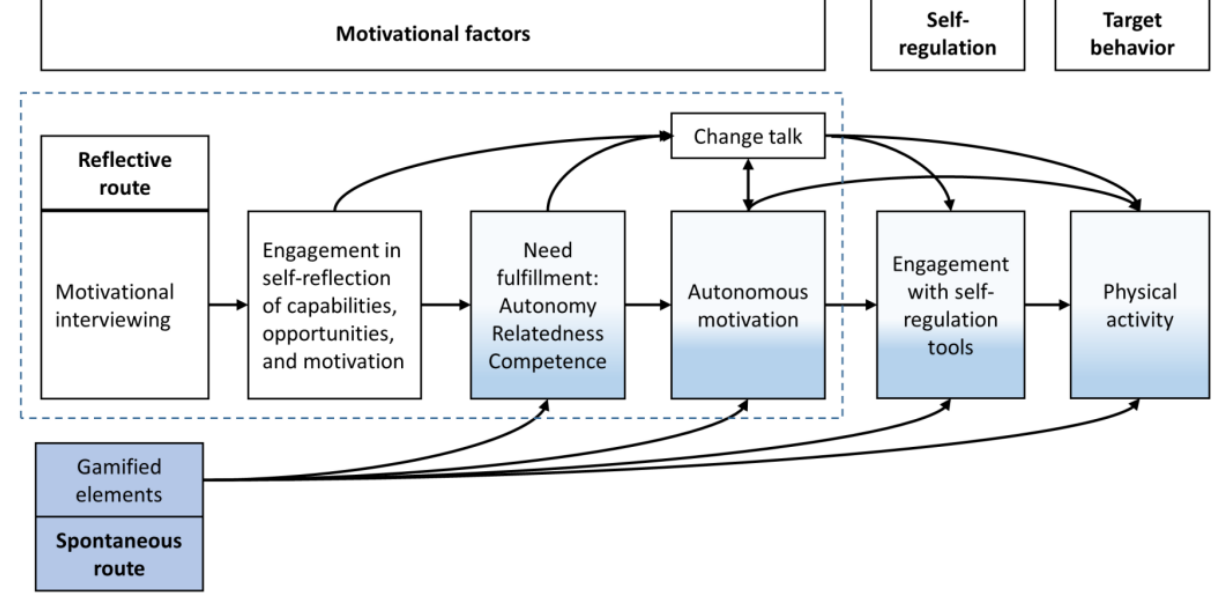
Figure 1. A proposed method for engaging users in the behavior change process. Digitalized motivational interviewing techniques help users engage in motivational self-reflection; identify reasons, capabilities, and opportunities for physical activity; and produce change talk. Gamification provides intrinsic pleasure with challenges and surprises. Together, these satisfy the self-determination theory’s psychological needs and support autonomous motivation. This increased awareness of the pleasure and benefits of exercise engages users in self-regulation, such as goal setting, planning, and self-monitoring, leading to increased physical activity. The dotted line shows the feasibility testing presented in this